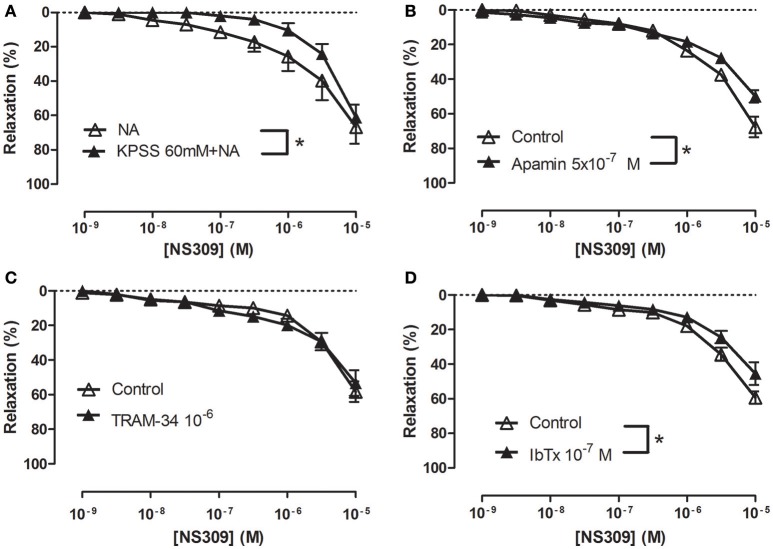
Role of potassium blockaged, apamin and iberiotoxin-sensitive channels in NS309 relaxations of rat corpus cavernosum. Average concentration-response curves for NS309 (A) in absence (n = 5) and the presence of KPSS 119 mM plus noradrenaline (n = 5), (B) in absence (n = 5) and the presence of a KCa2 blocker apamin (0.5 μM, n = 5), (C) in the absence (n = 4) and the presence of a blocker of KCa3.1 channels, TRAM-34 (1 μM, n = 4), (D) in the absence (n = 5) and the presence of a blocker of KCa1.1, iberiotoxin (IbTx, 0.1 μM, n = 5). Data are expressed as means ± S.E.M. *P ≤ 0.05, two-way ANOVA compared to control preparations with endothelium.